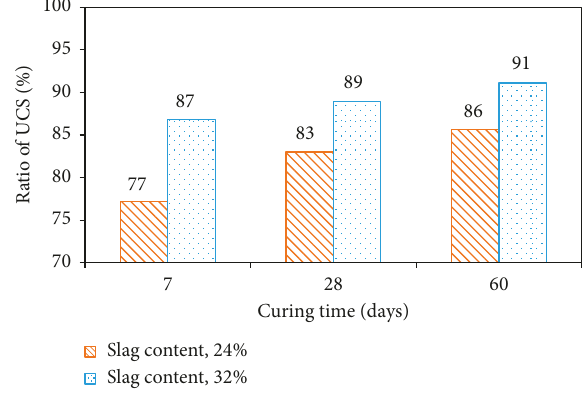
Figure 10: UCS ratio results for